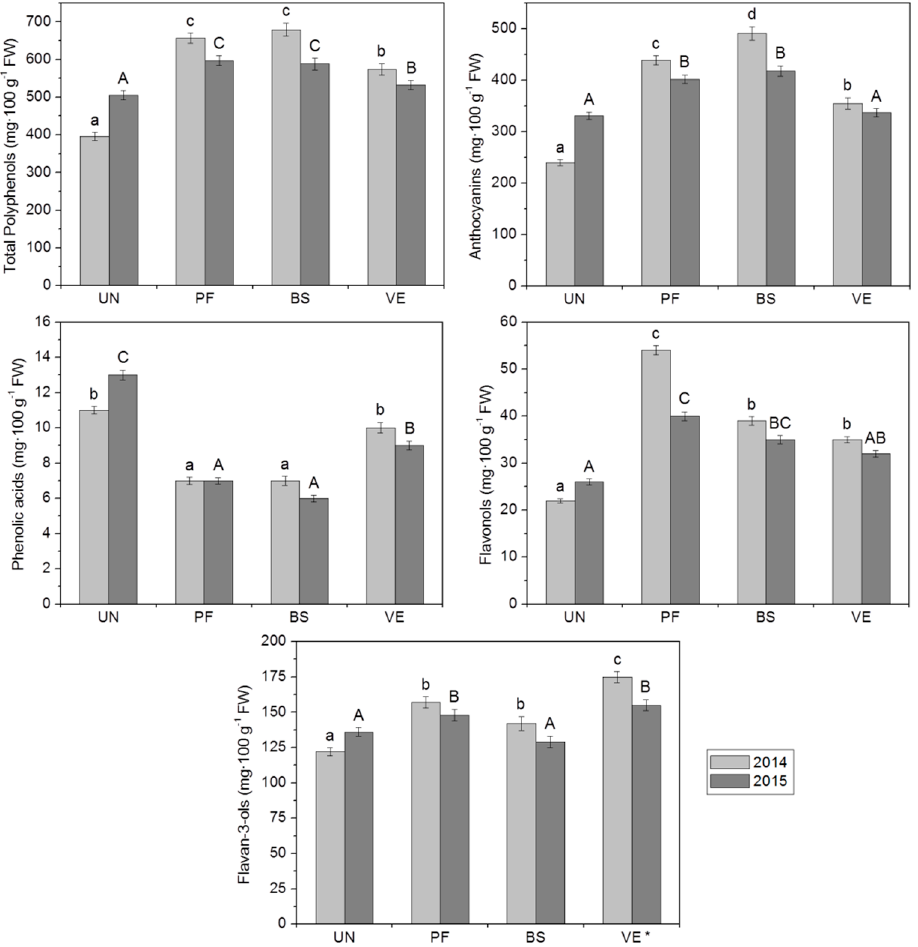
Figure 1. The polyphenol content in mg · 100 g − 1 FW of grape cv. Regent in the two years studied, as related to different leaf removal treatments. * UN: Untreated (no leaf removal), PF: Pre-flowering, BS: Berry-set, VE: Véraison. Data represented by mean ± SD: standard deviation. Means having same letter were not significantly different by Tukey’s comparison p < 0.05 level. Lowercase letters indicate the means of 2014, capital letters of